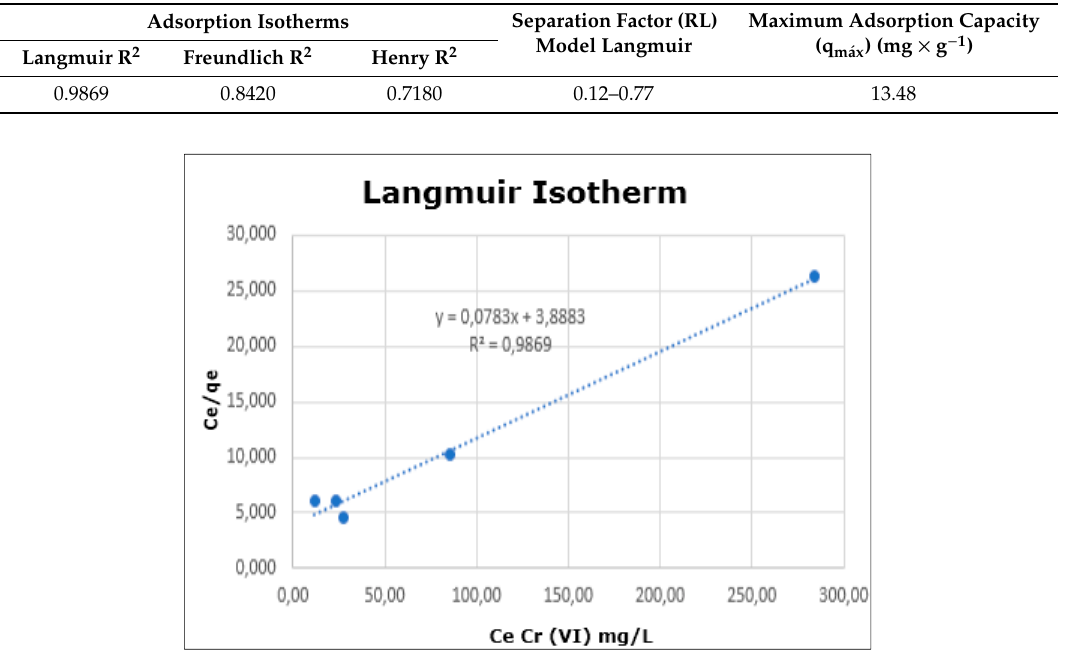
Table 3. Datos de isotermas de adsorci ó n con CP.